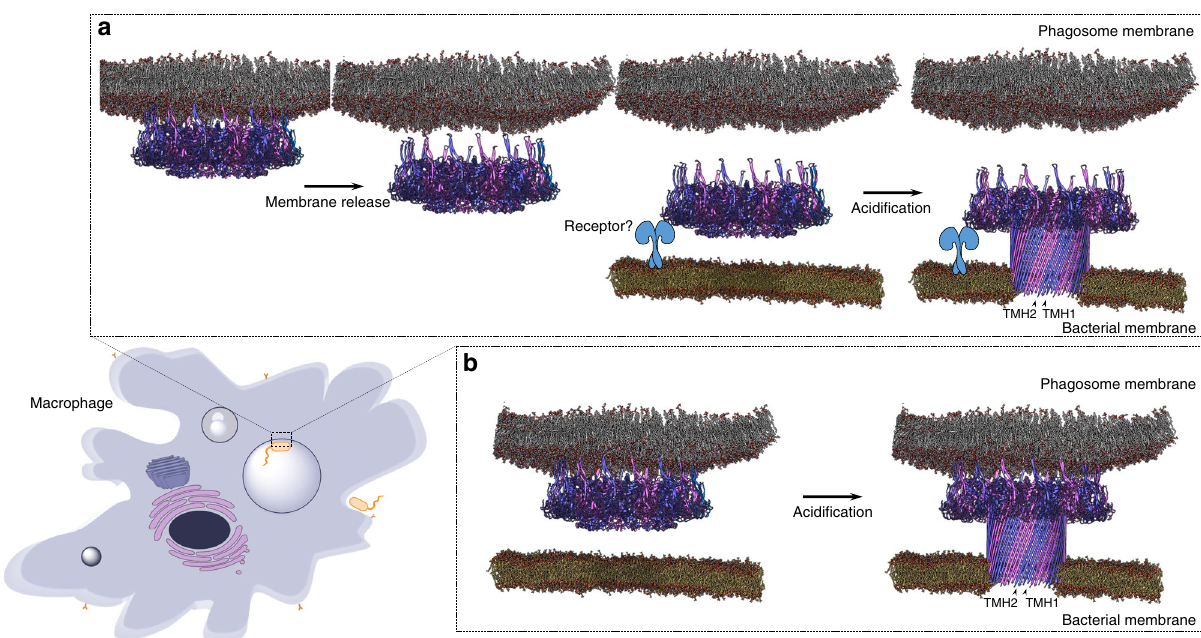
Fig. 5 Schematic illustrating two proposed mechanisms for control of MPEG1 function. a MPEG1 prepores (alternate subunits coloured) are localised to the phagolysosome membrane, either through the transmembrane helix or the MABP β -hairpin. Upon acidi fi cation or proteolytic activity, the prepores are released from the membrane into the phagosome lumen. Via an unknown means these recognise engulfed target membranes and form pores. b Alternatively, prepores remain tethered to the phagosome membrane inner lea fl et via the MABP β -hairpin and are triggered to form pores in engulfed bacteria upon acidi fi